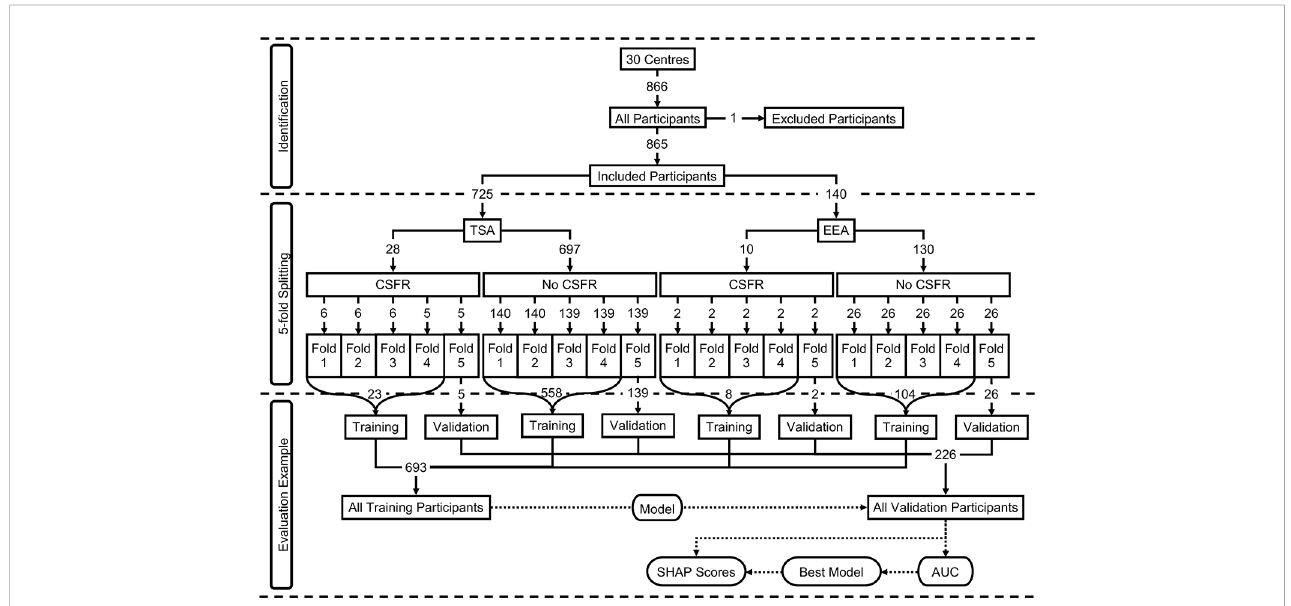
FIGURE 1 Participants breakdown displayed as a fl owchart. The top section (identi fi cation) displays the included and excluded participants. The middle section (5-fold splitting) displays how the 5-folds were created, including the breakdown by surgical approach and outcome. The predictor distributions of the